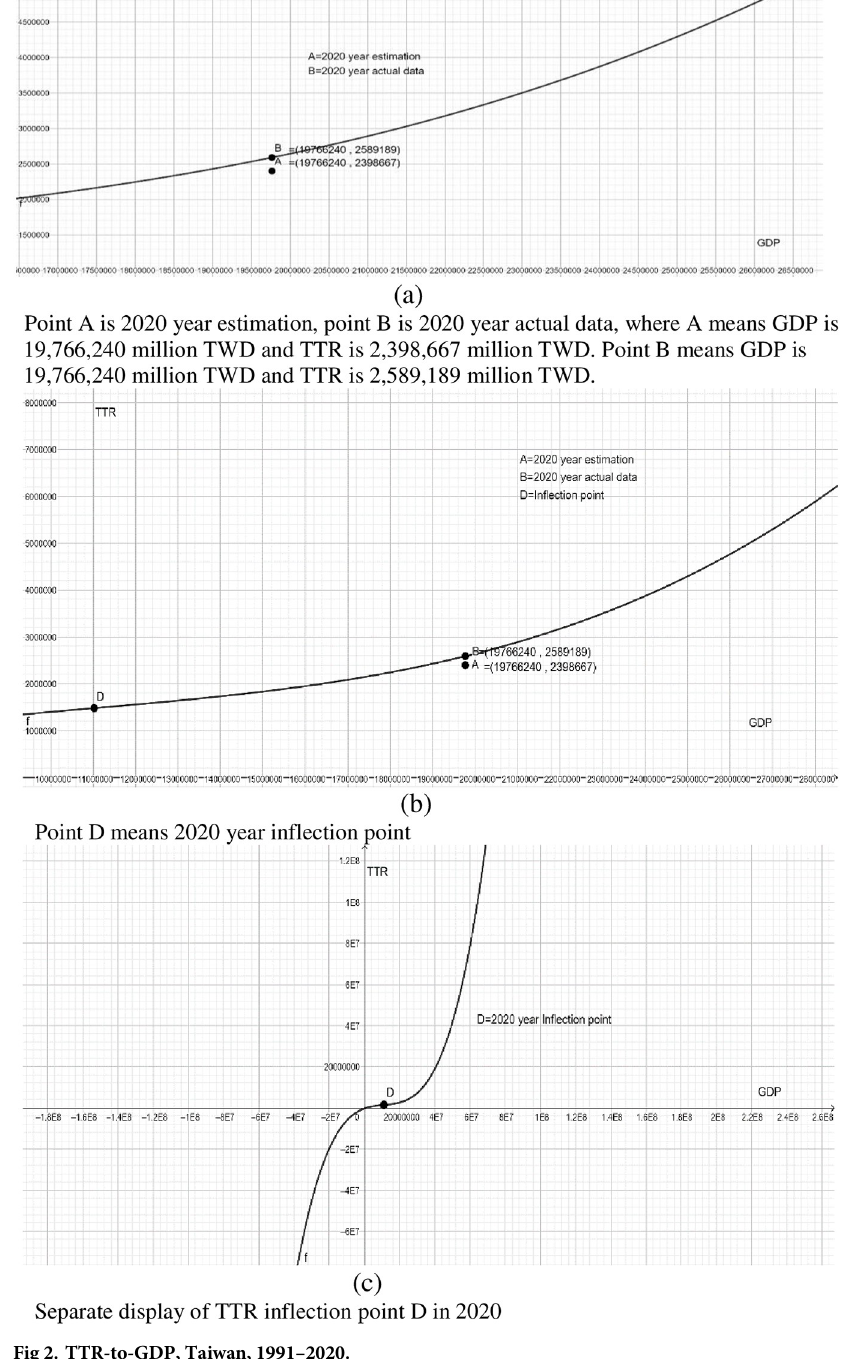
Fig 2. TTR-to-GDP, Taiwan, 1991–2020.